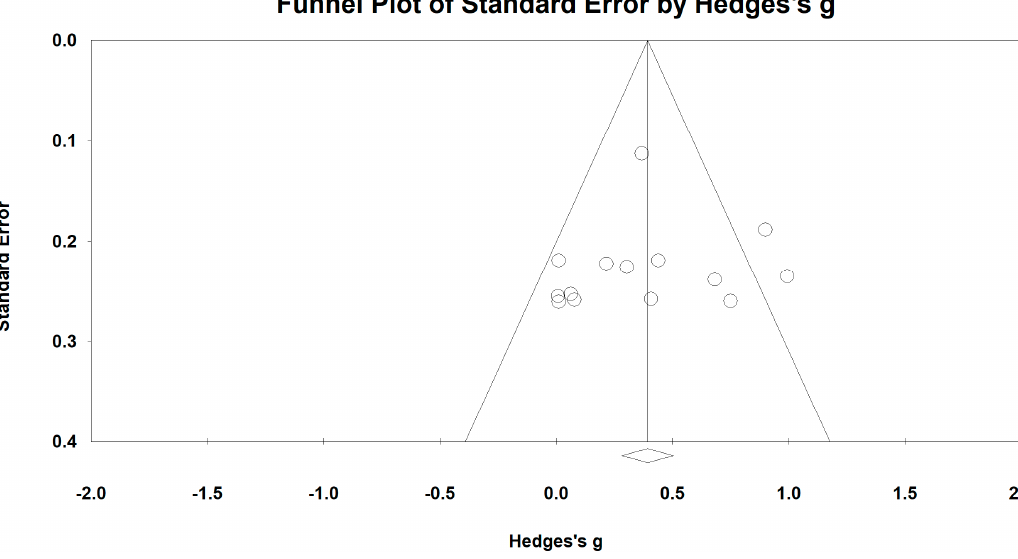
Figure 6. Funnel plot of publication bias for FEV 1 %.